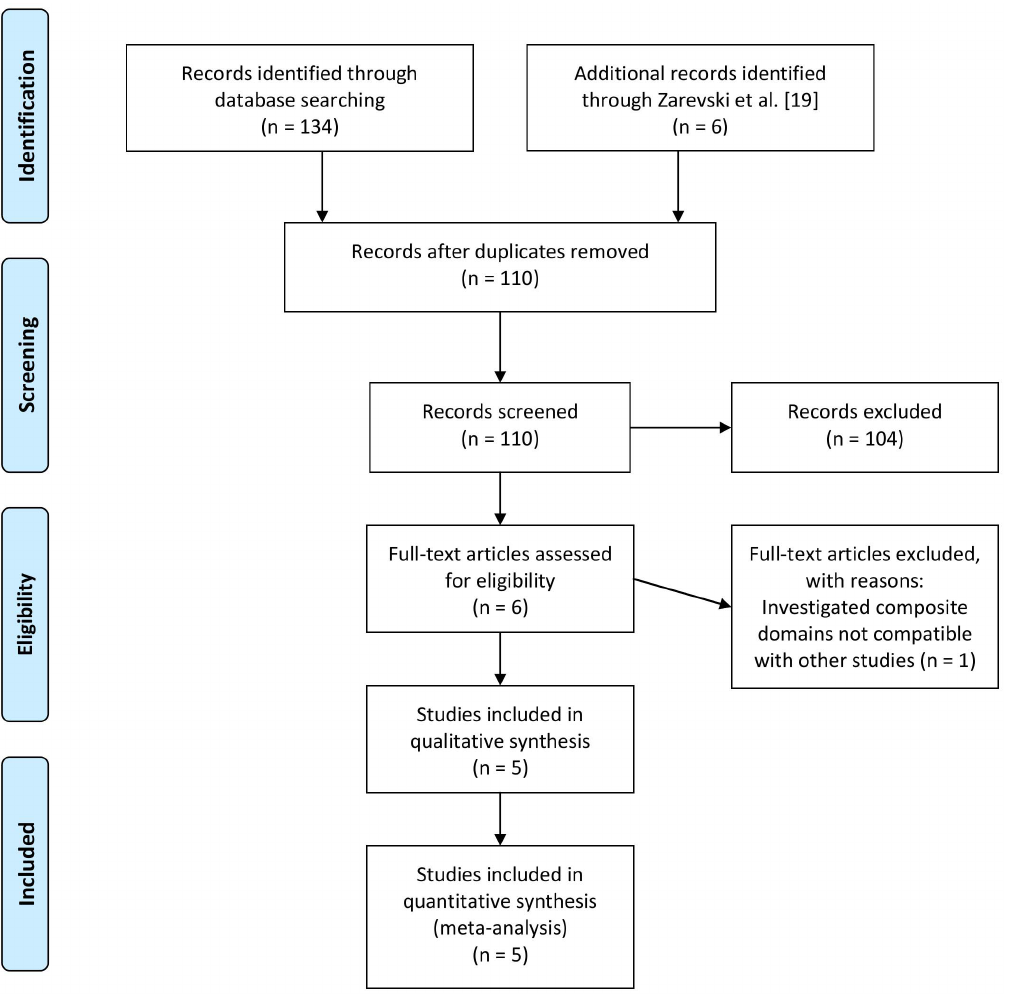
Figure 1. PRISMA flow diagram.